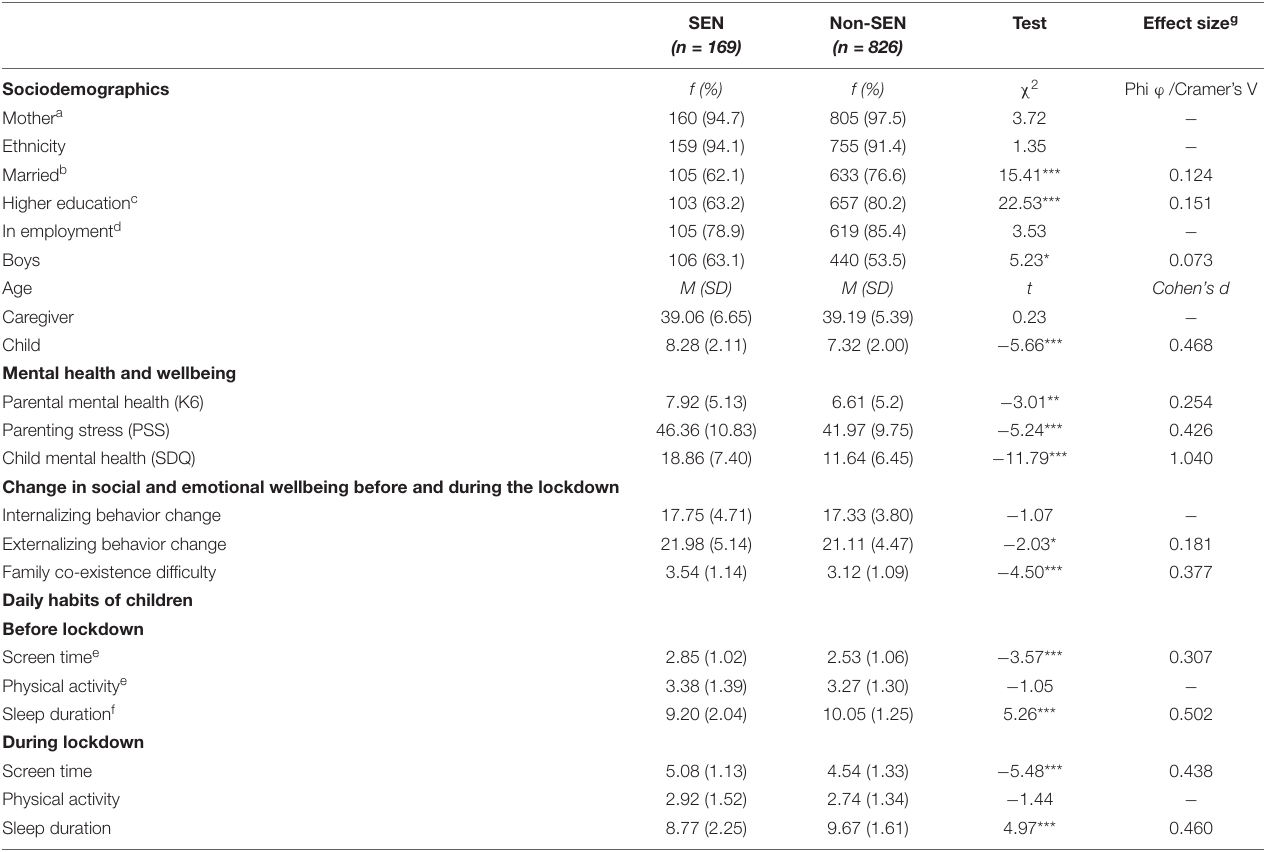
TABLE 1 | Between-group differences by participant